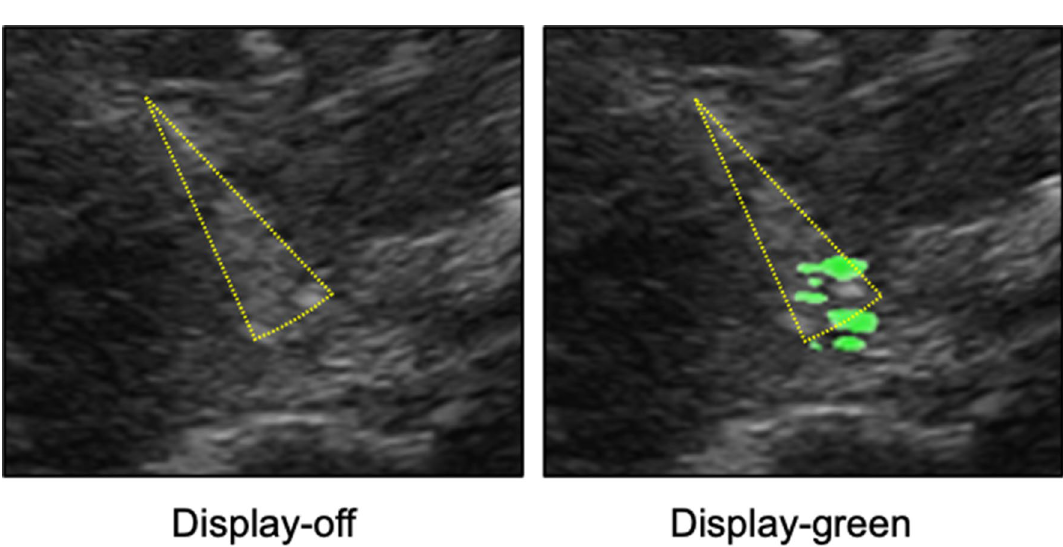
Figure 6. Artifacts cause multiple needle tips. Sciatic nerve block on the left side of the cadaver (See Supplemental Digital Content nos. 11 and 18). Combination of reverberation artifact and bayonet artifact (dotted yellow triangle) may cause an illusion of multiple needle tips (display-green; Supplemental Digital Content no. 18). The needle tip without displaying photoacoustic ultrasound cannot be identified